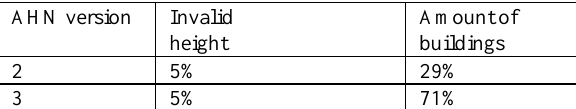
Table 2. Amount of models with invalid height per AHN version. As of March